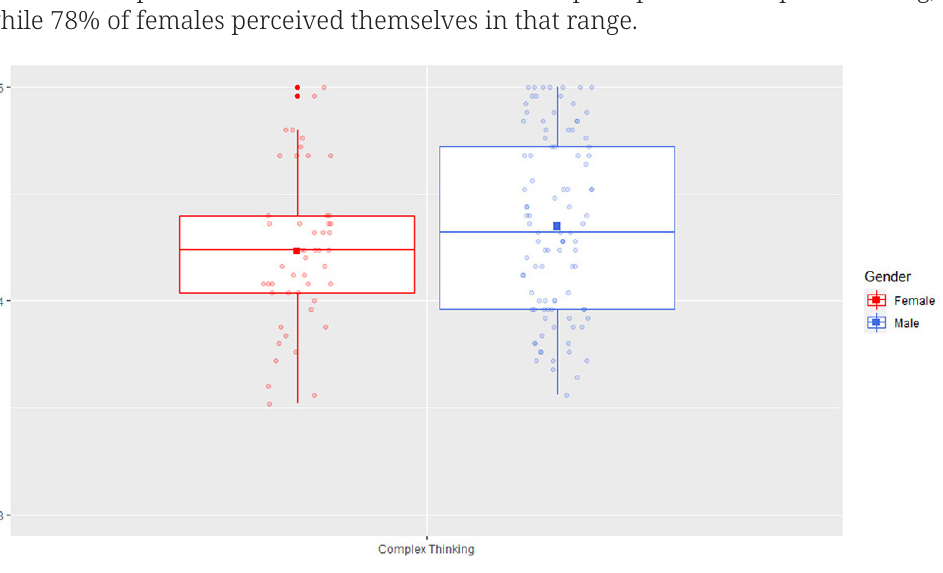
Fig. 3. Boxplot analysis: complex thinking competency by gender